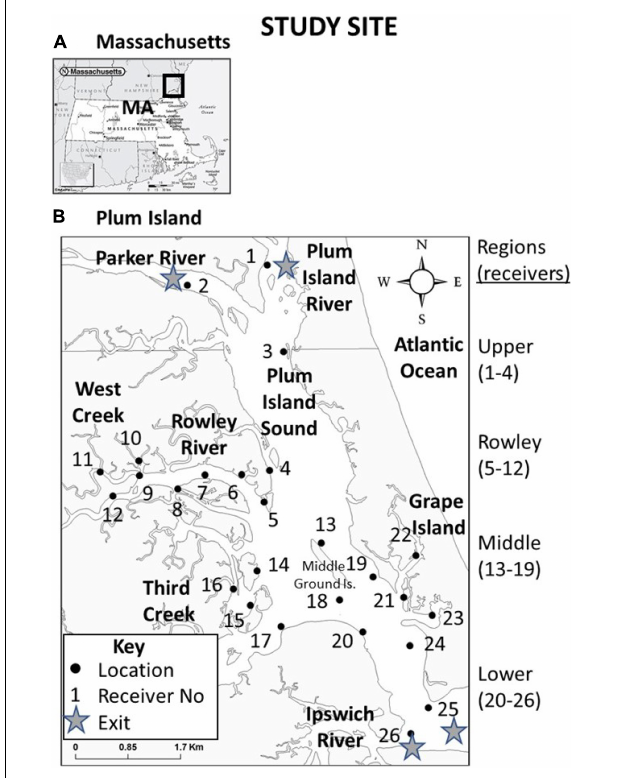
FIGURE 1 | (A) Location of our study site in Plum Island Estuary (PIE) in northeastern MA, United States, and (B) study site characteristics including landmarks, confluences, geographic regions, and locations of receivers by number. Filled dots indicate stationary receiver locations. Receivers were placed to test fish use of three types of physical sites (exits, confluences, and non-confluences). Exit locations were at the four locations (receiver numbers 1, 2, 25, and 26). Confluences are locations where two smaller water bodies merge. To test confluences, we deployed three receivers each at Rowley River mouth (receivers 5, 6, and 8); West Creek (receivers 9, 10, and 11); Third Creek (receivers 14, 15, and 16); and Grape Island (receivers 21, 22, and 23). The non-confluence site type included six locations not directly adjacent to any river mouth (receiver numbers 3, 12, 13, 18, 19, and 20). A few receivers were deployed to detect fish in underrepresented areas and to provide greater spatial coverage (receivers 4, 7, 17, and 24). We deployed receivers in four regions (Upper region = receivers 1–4; Rowley River region = receivers 5–12; Middle region = receivers 13–19; and Lower region = receivers 20–26). All fish included in our analysis encountered all of the same receivers of an identical model deployed using an identical